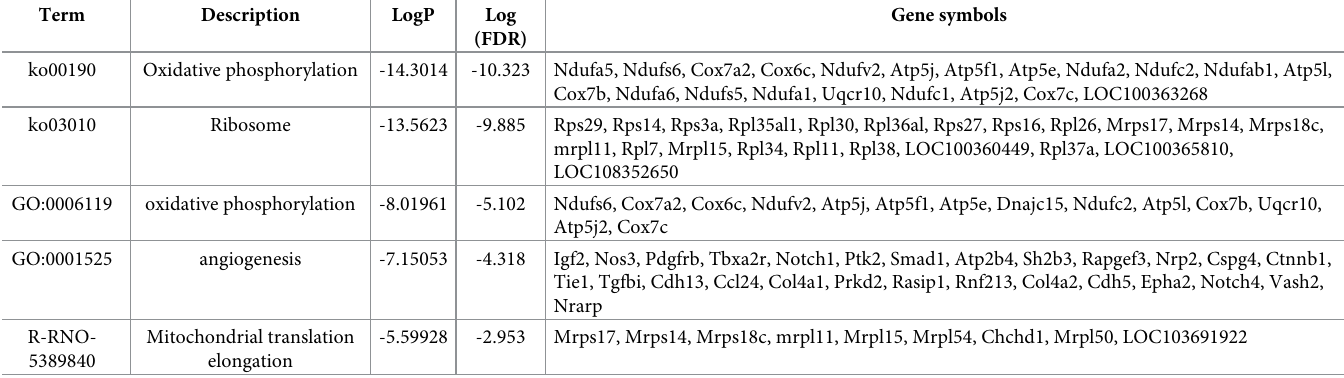
Table 5. Summary of top five significant pathways enriched by the 345 late onset